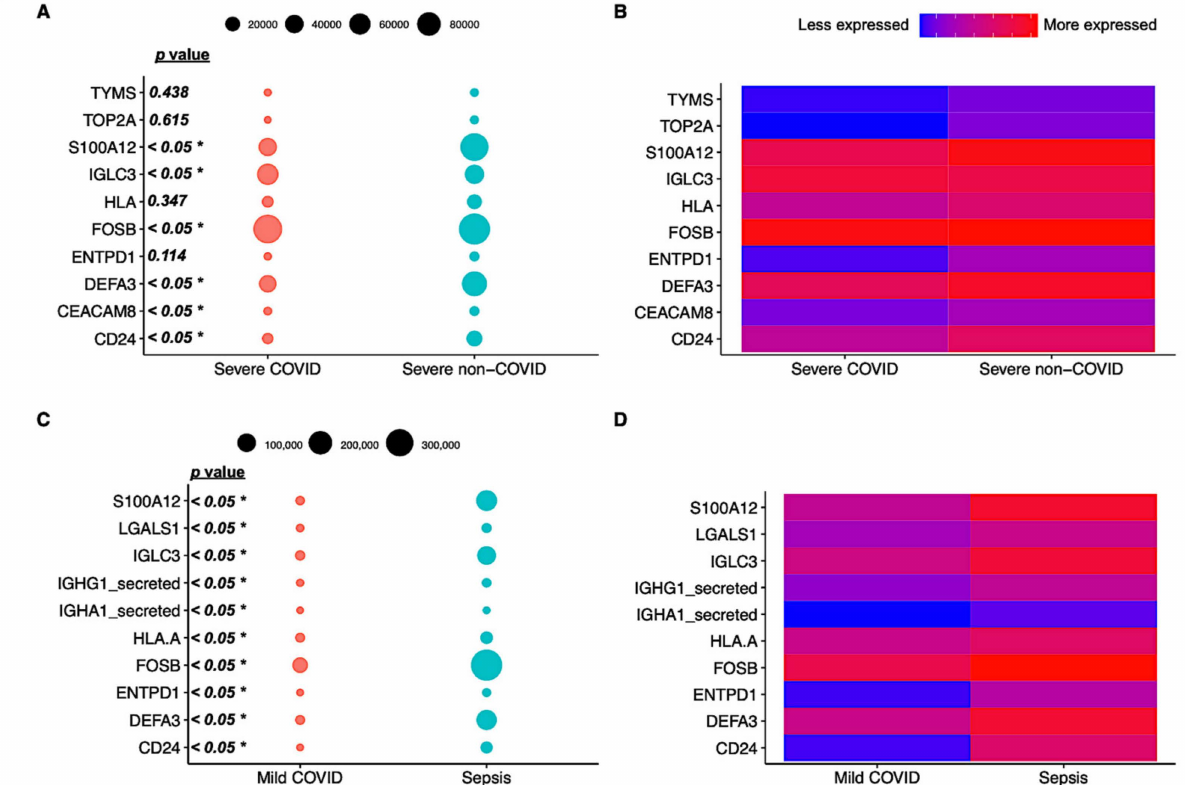
Figure 2. Distinctive single-cell level expression profiles of mild and severe forms of COVID-19 and bacterial sepsis. Severe forms of disease differed in expression levels of the genes S100A12, FOSB, DEFA3, CEACAM8, and CD24 ( A ) from which all genes presented an upregulated profile ( B ) in patients with septic shock (i.e., non-COVID). The mild form of disease, all 10 genes showed significantly different expression rates ( C ), i.e., *S100A12, *LGALS1, *IGLC3, *IGHG1-secreted, IGHA1-secreted, HLA-A, FOSB, ENTPD1, DEFA3, and CD24 were found to be upregulated in non-COVID patients ( D